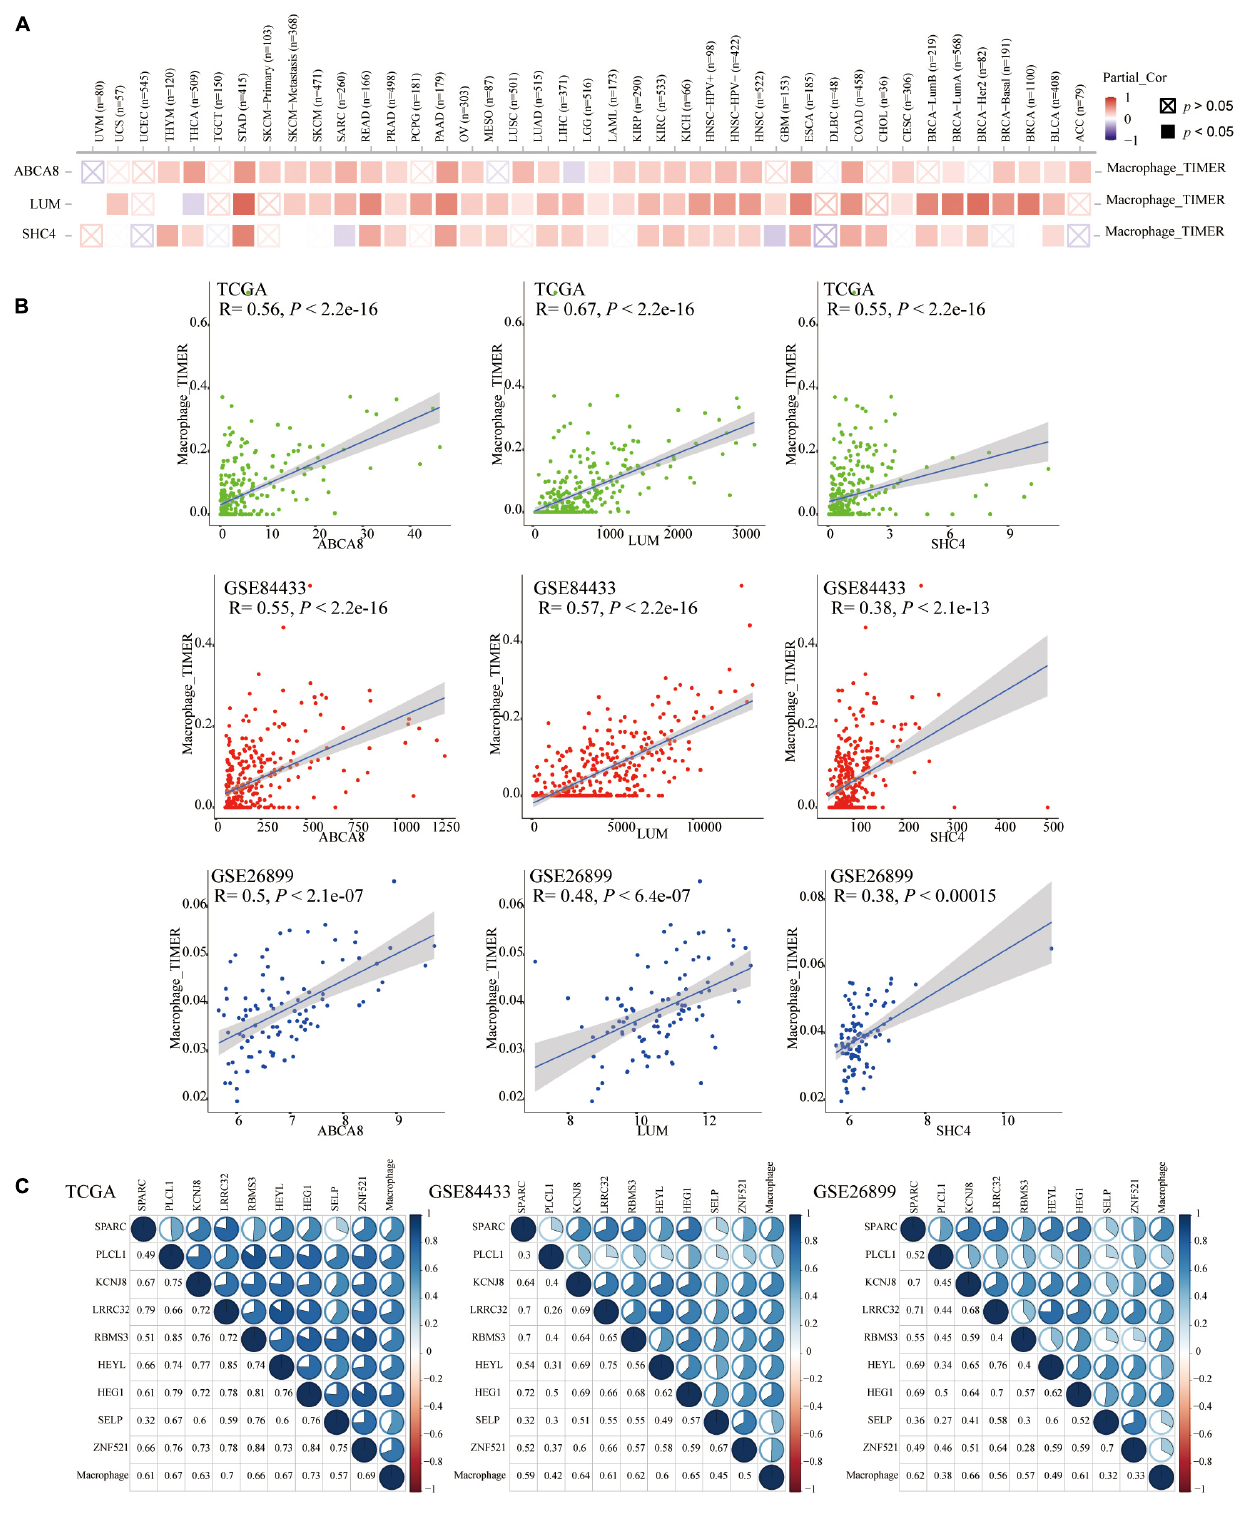
Frontiers in Cell and Developmental Biology |